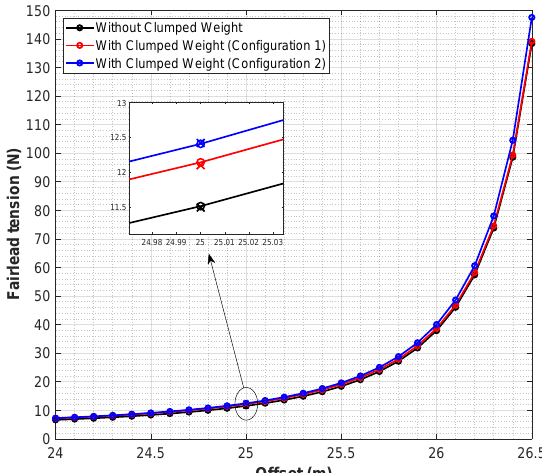
Figure 11. Variation of the tension with offset distance in all configurations. Experimental values are added to the figure with crossed symbols ‘x’ in the detailed